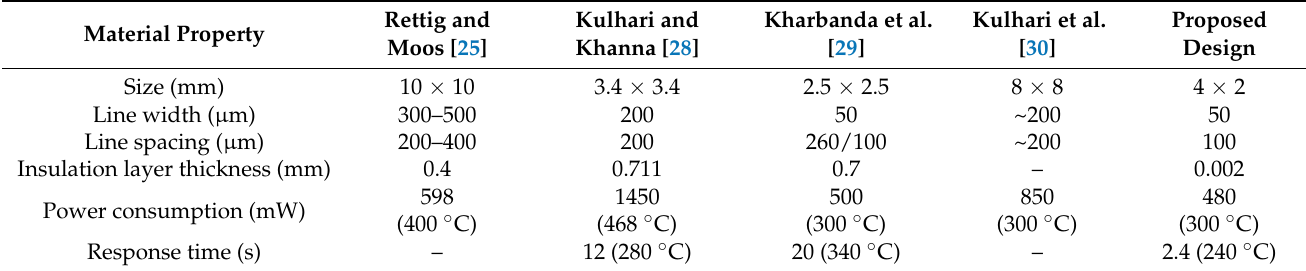
Table 3. Comparison of different ceramic micro-hotplate